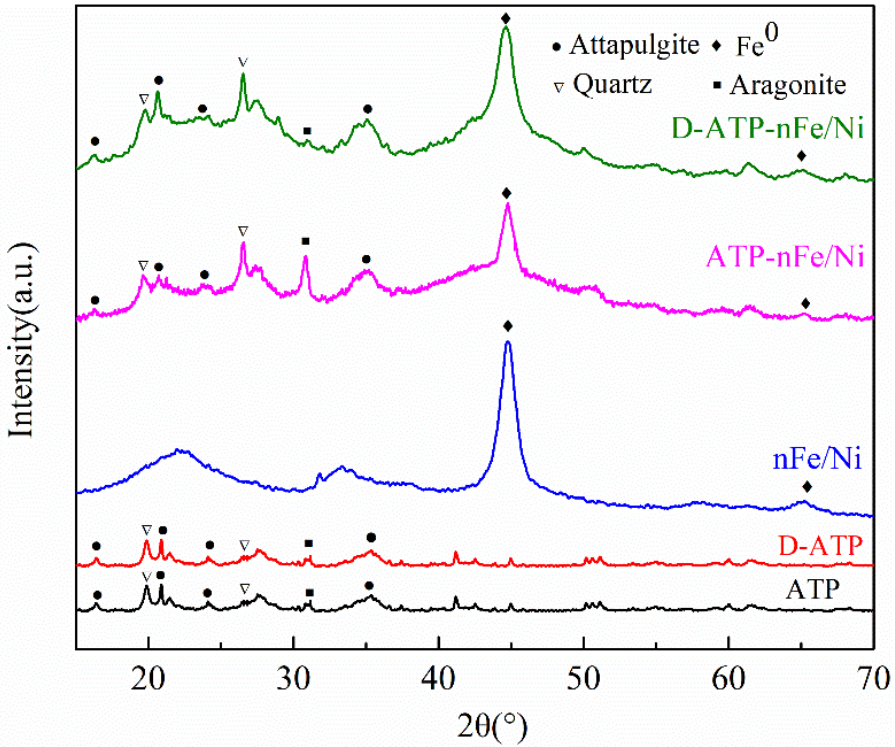
Figure 2. XRD patterns of ATP, D-ATP, nFe/Ni, ATP-nFe/Ni and D-ATP-nFe/Ni.